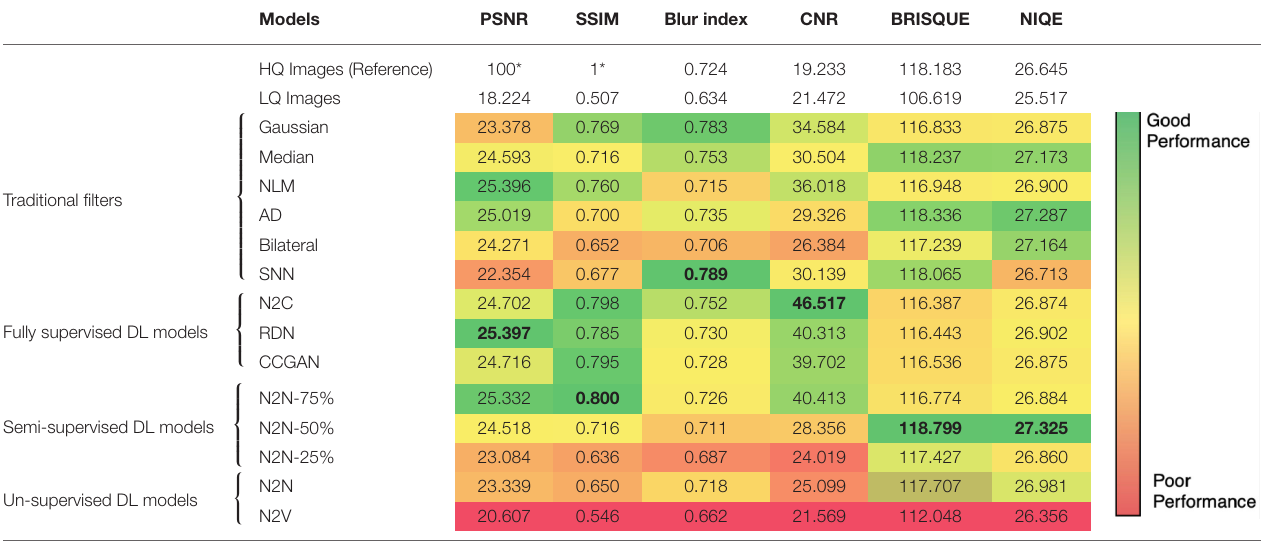
TABLE 6 | Quantitative comparison of denoising algorithms using standard denoising evaluation metrics.